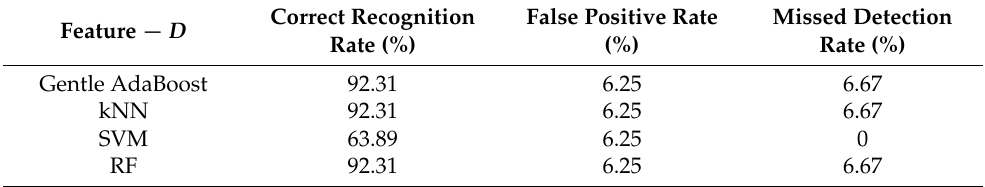
Table 4. Experimental results of constructing different recognition models based on multifractal